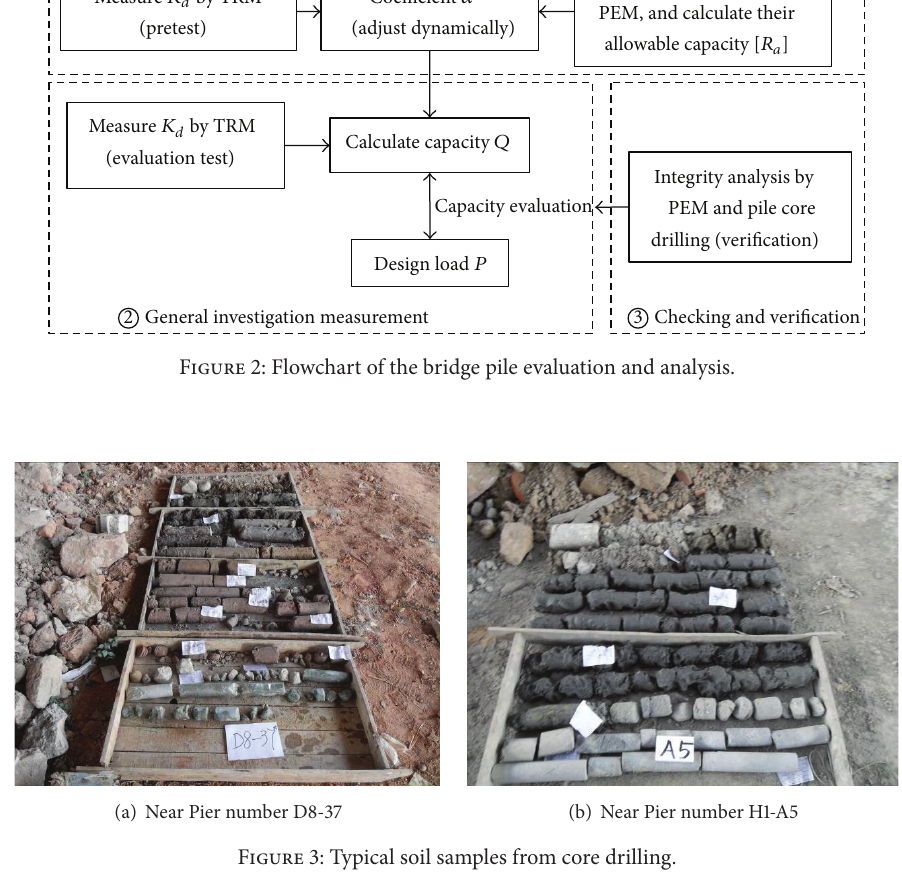
Figure 3: Typical soil samples from core